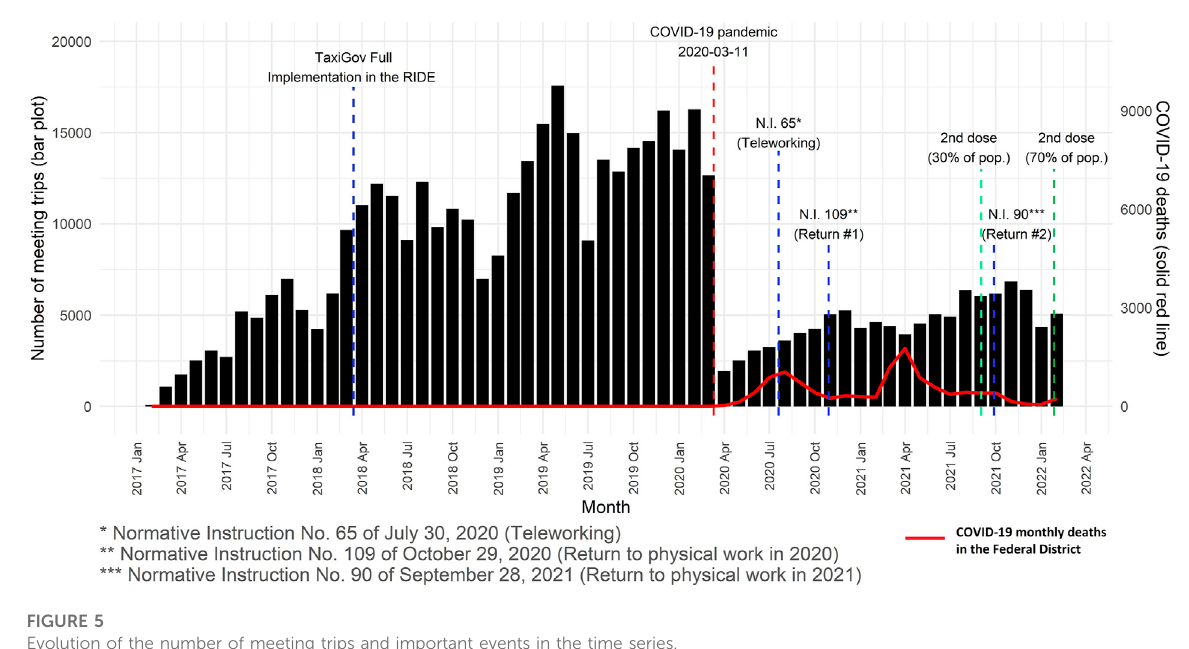
FIGURE 5 Evolution of the number of meeting trips and important events in the time